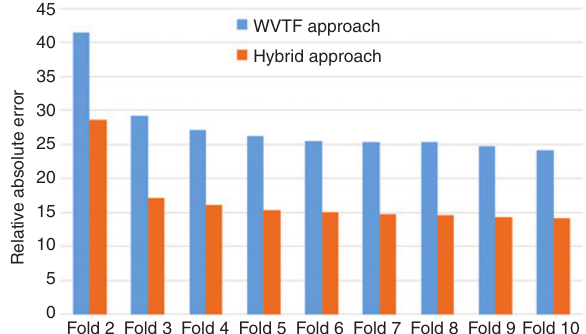
Figure 3: Cross-folding Validation on the Training Data